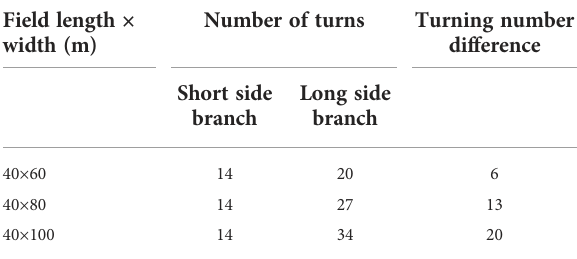
TABLE 3 Calculation method of distance between stacking points. Crop row